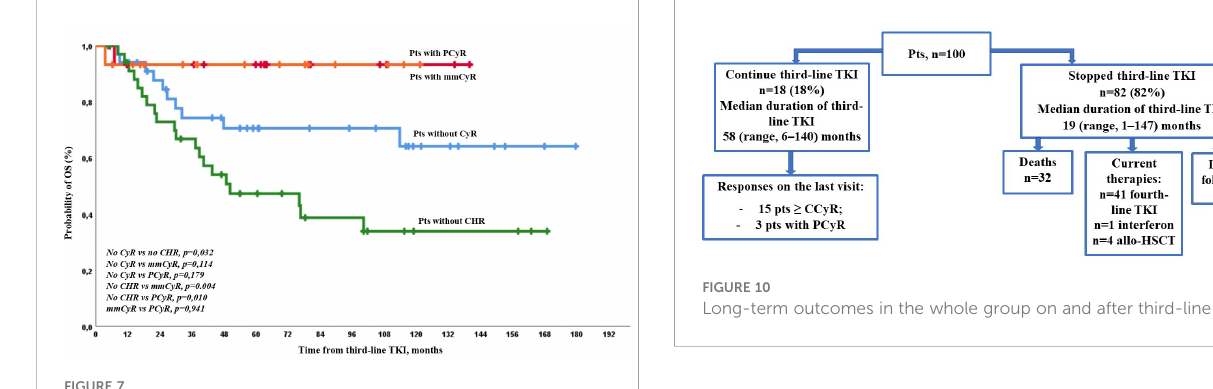
FIGURE 7 OS on third-line therapy according to the depth of response at baseline.